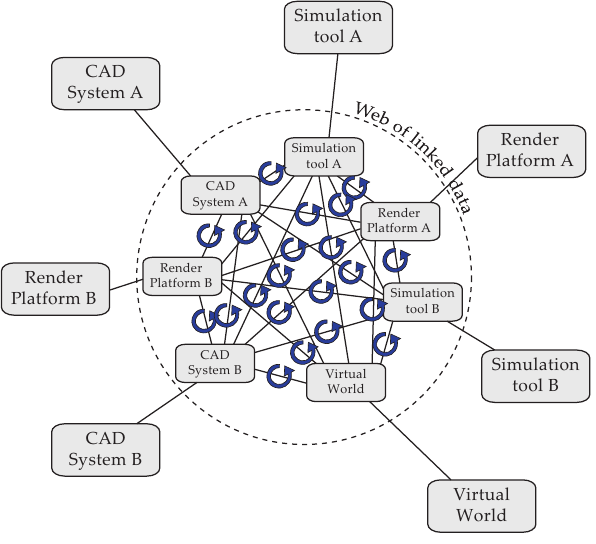
Figure 9. In the linked data approach, information is linked on the data level. This results in a web of linked data that is accessible for any application that wants to use it. Furthermore, the interface points between information systems (blue circular arrows) are now to be implemented on the data